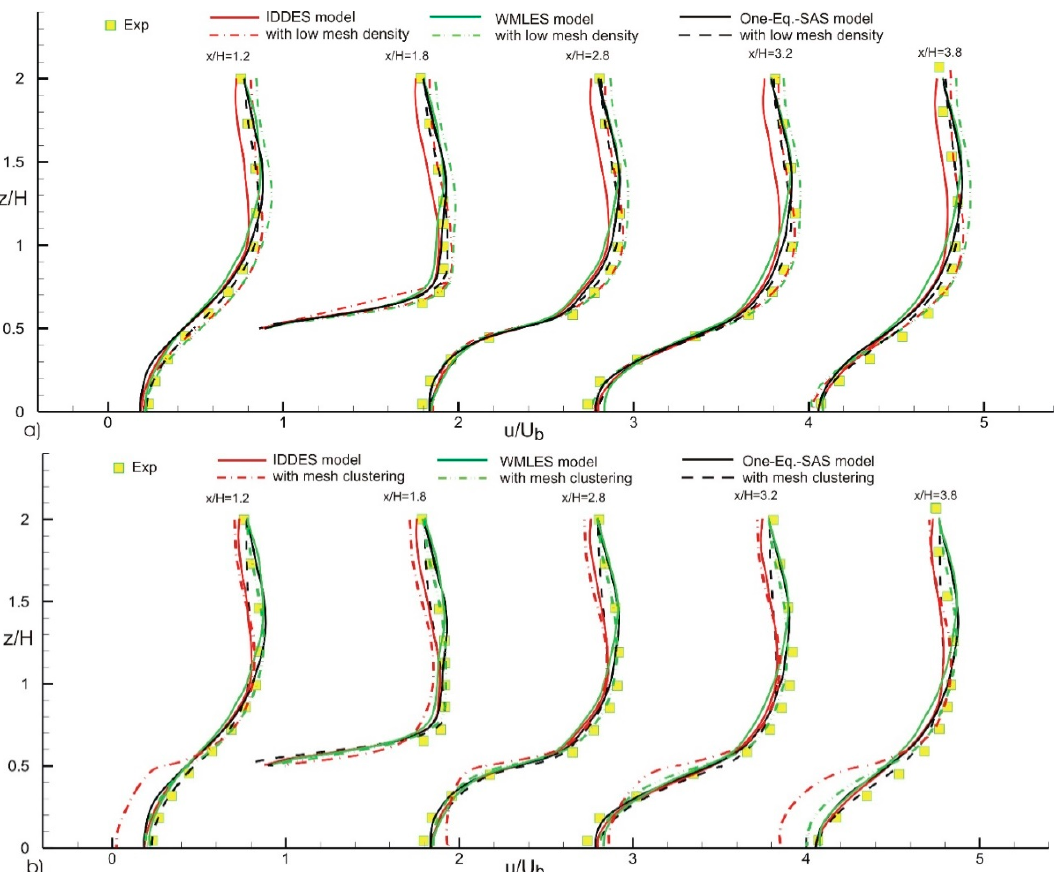
Figure 3. Effect of ( a ) mesh density, and ( b ) mesh clustering on the average streamwise velocity in the XY plane cutting through the center of the cube at z/H = 0. Each successive x/H profile starting from the one at x/H =1.2 is offset by one unit from the previous profile.